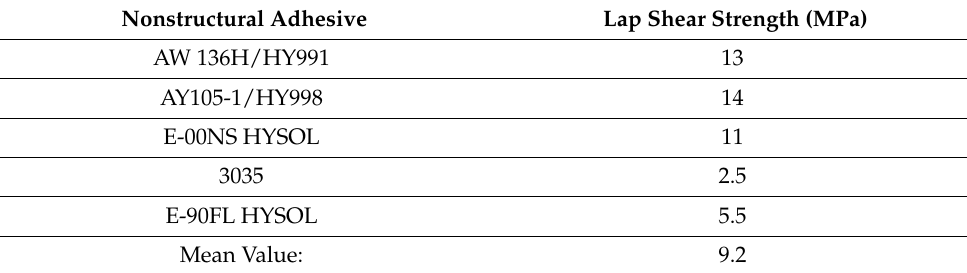
Table 15. Lap shear strength of nonstructural adhesives.